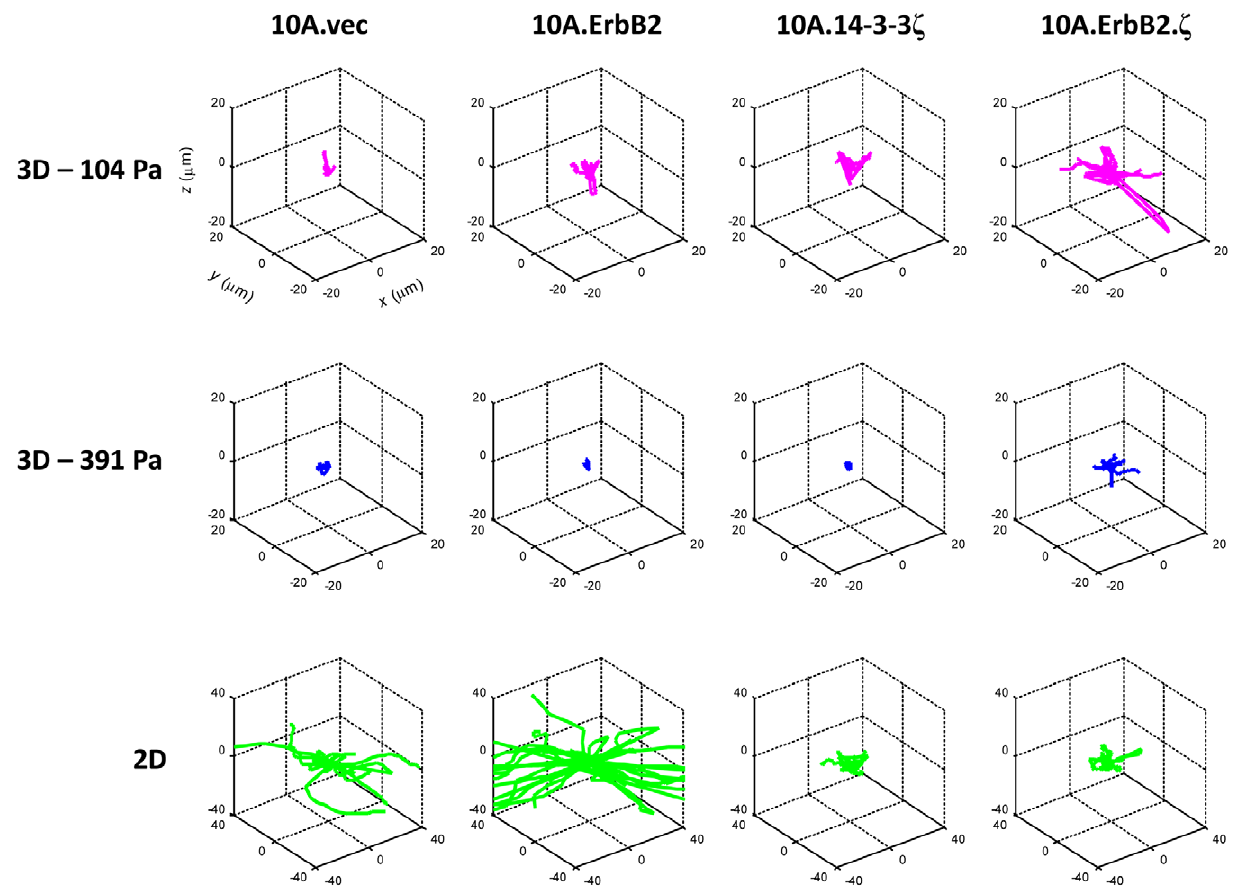
Figure 3. Windrose plots of MCF10A cell migration. Top row lists cell line; left column lists matrix condition. Cells in 2D matrices exhibited the highest degree of motility, followed by cells within compliant (104 Pa) 3D matrices and then by cells within stiff (391 Pa) 3D matrices.